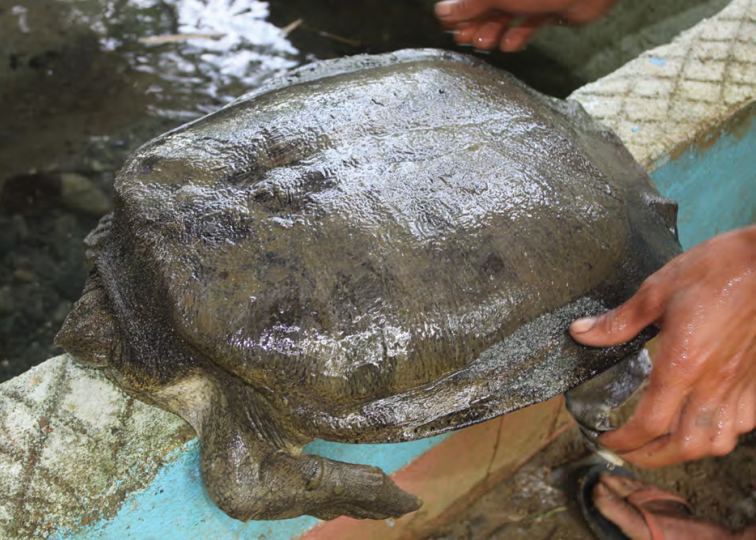
Pelochelys cantorii from the vicinity of St Victoria (specimen not collected); Photo: MVW.